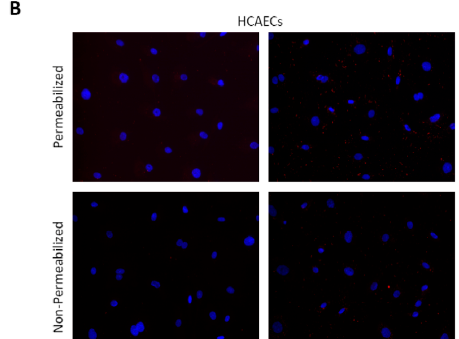
Figure 6. CTHRSSVVC-phage is internalized by macrophages. CTHRSSVVC-phage is internalized by J774A.1 mouse macrophage but not human endothelial cells (HCAECs). J774A.1 cells ( A ) or HCAECs ( B ) were incubated at 37 °C with CTHRSSVVC or insertless Fd-tet phages for 8 h to allow phage internalization. Membrane bound phages were removed by cell washing, internalized phages (red) and cell nucleus (blue) revealed by cell permeabilization, and phage staining using an anti-bacteriophage antibody. Non-permeabilized cells indicate the successful removal of cell surface bound phages. Magnification = 100×.